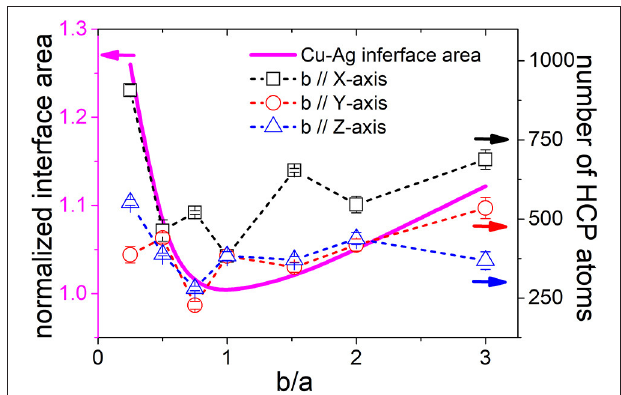
FIGURE 3 | Number of non-fcc atoms vs. AR for the differently shaped ellipsoidal particles after the relaxation process. Cu–Ag interface area normalized by the one of the spherical particle is also given for